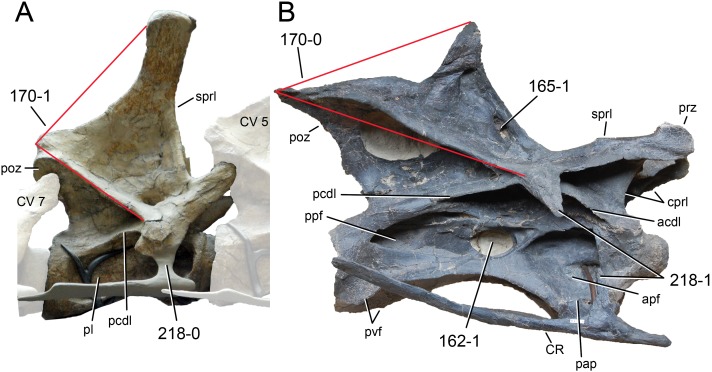
Cervical vertebra 6 of flagellicaudatans.Cervical vertebra 6 of Dicraeosaurus hansemanni MB.R.4886 (A) and Galeamopus sp. SMA 0011 (B) in right lateral view. Note the large, rounded pneumatic foramen marking the anterior end of the posterior pneumatic fossa in Galeamopus (B; C162-1), the elongate foramen in the neural spine (B; C165-1), the right (A; C170-1), or acute angles (B; C170-0) between the spinopostzygapophyseal and the postzygodiapophyseal laminae, and the vertical (A; C218-0) or posteriorly inclined tuberculum (B; C218-1). Abb.: acdl, anterior centrodiapophyseal lamina; apf, anterior pneumatic fossa; cprl, centroprezygapophyseal lamina; CR, cervical rib; CV 5, cervical vertebra 5; pap, parapophysis; pl, pleurocoel; poz, postzygapophysis; ppf, posterior pneumatic fossa; prz, prezygapophysis; pvf, posteroventral flanges; sprl, spinoprezygapophyseal lamina. Scaled to the same cotyle height.